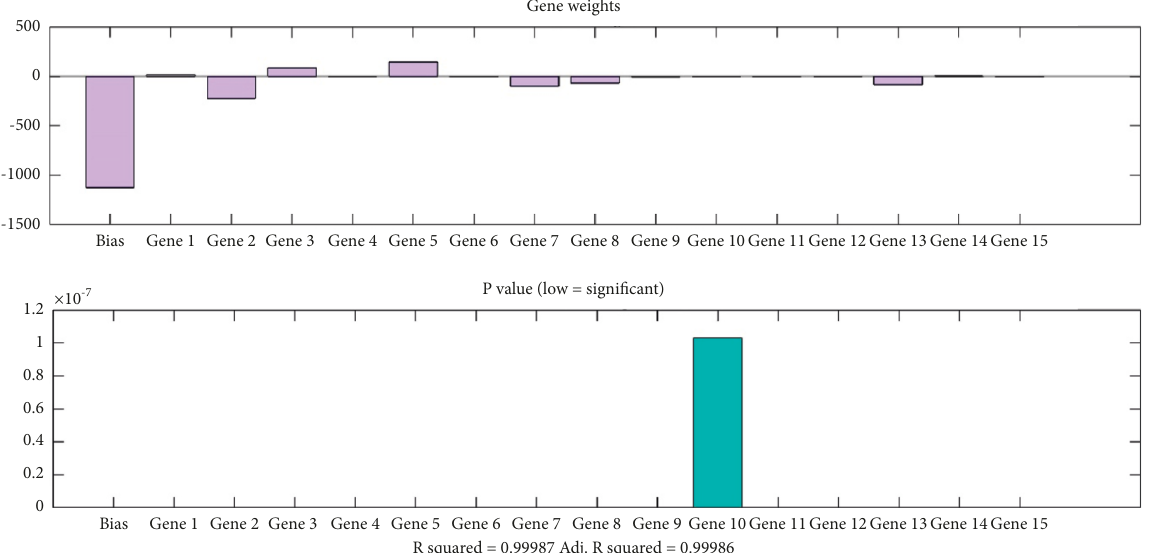
Figure 6: The value of gene weight in the GEP process.